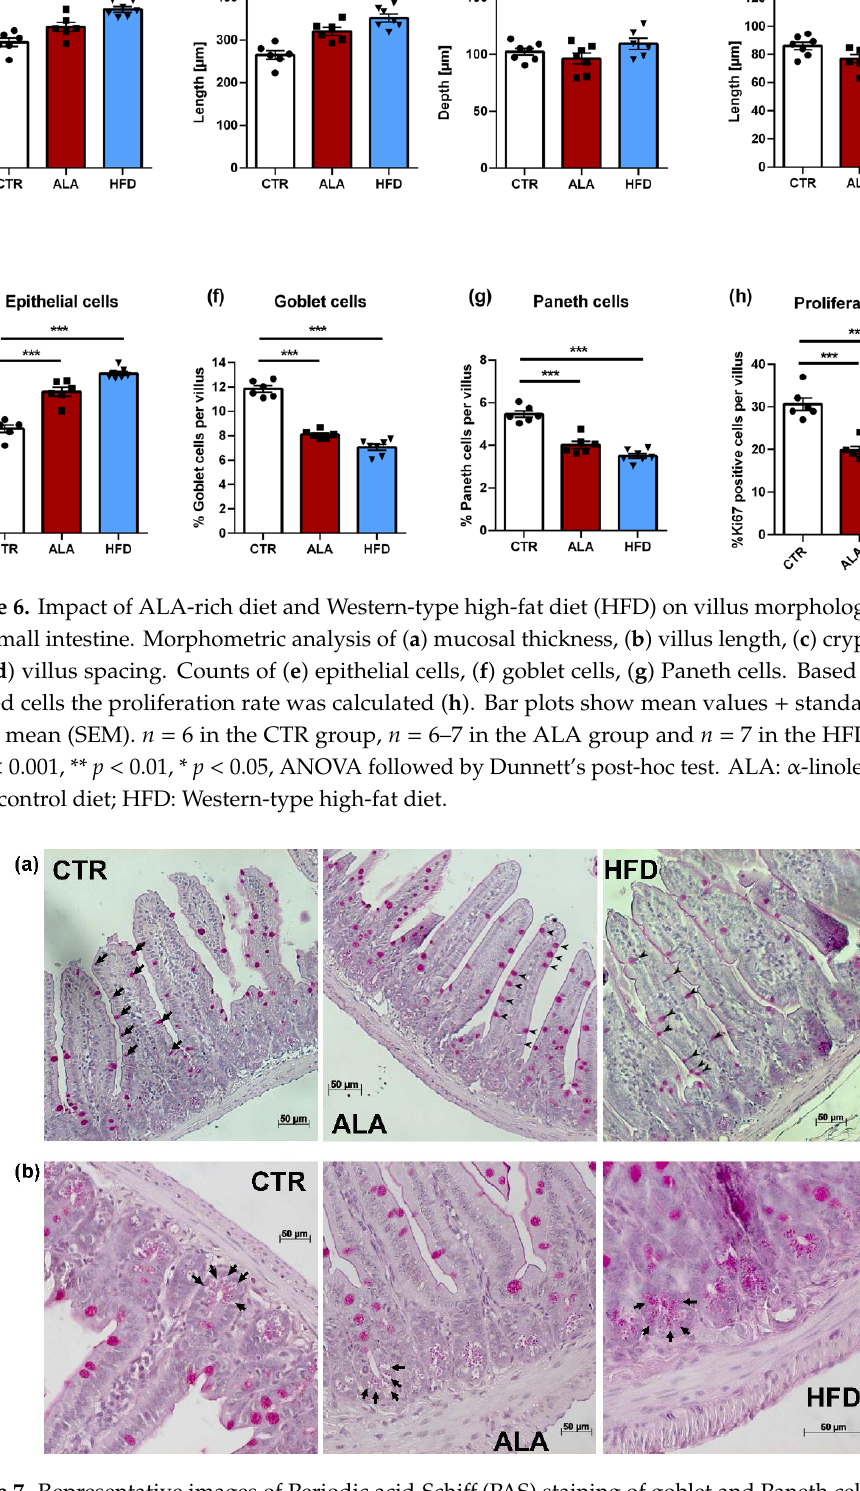
Figure 7. Representative images of Periodic acid-Schiff (PAS) staining of goblet and Paneth cells under different dietary conditions. Panel ( a ) shows PAS-stained goblet cells indicated by black arrows/arrow heads. PAS-stained Paneth cells in intestinal crypts are indicated with black arrows in panel ( b ). ALA: α-linolenic acid-rich diet; CTR: control diet; HFD: Western-type high-fat diet.